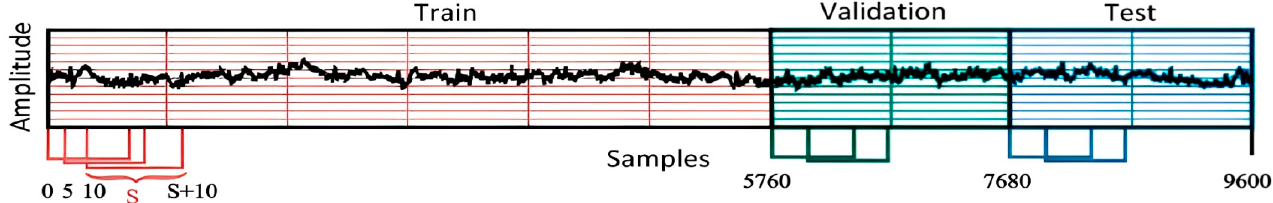
Figure 6. Data Augmentation Schema